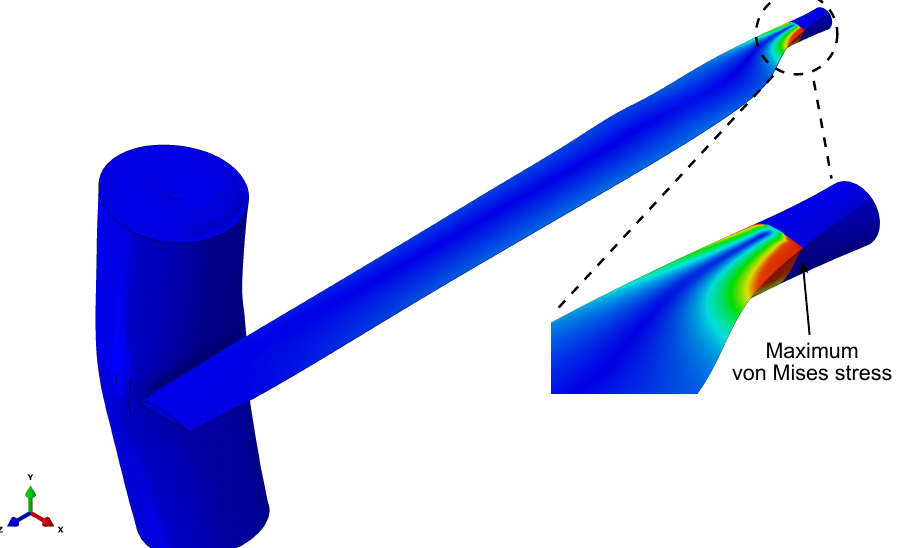
Figure 3. Visualization of stress distribution at the fixed end of the blade during impact; the contour plot represents von Mises stress